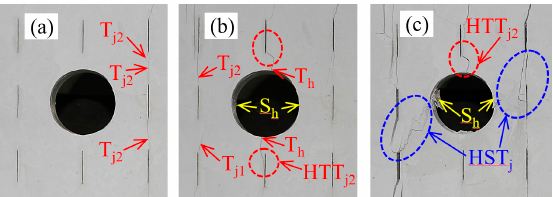
Figure 9. Cracking process around the hole in specimen HC90 of collapse mode I h : ( a ) σ 1 = 0.31 σ p , ε 1 = 0.42 ε p ; ( b ) σ 1 = 0.87 σ p , ε 1 = 0.89 ε p , and ( c ) σ 1 = 0.45 σ p , ε 1 = 1.65 ε p (Red and blue dotted circles represent crack coalescence types without or with participation of shear crack, respectively).